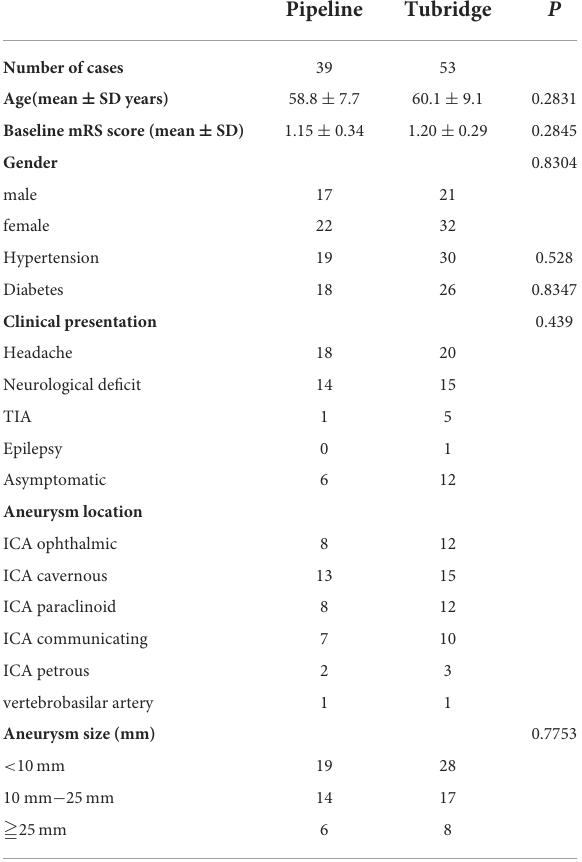
TABLE 1 Baseline characteristics of analyzed